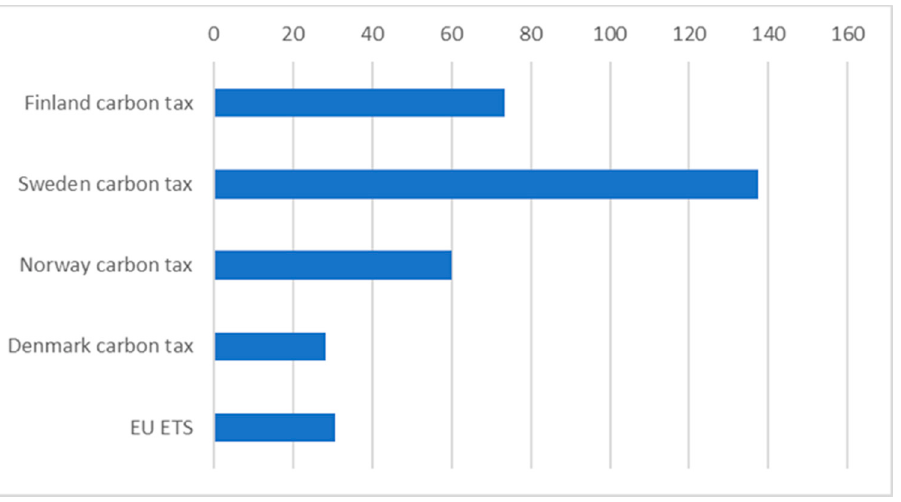
Figure 1. Examples of carbon prices [US$/tCO 2 e], data from [50] (ETS: Emissions Trading System).